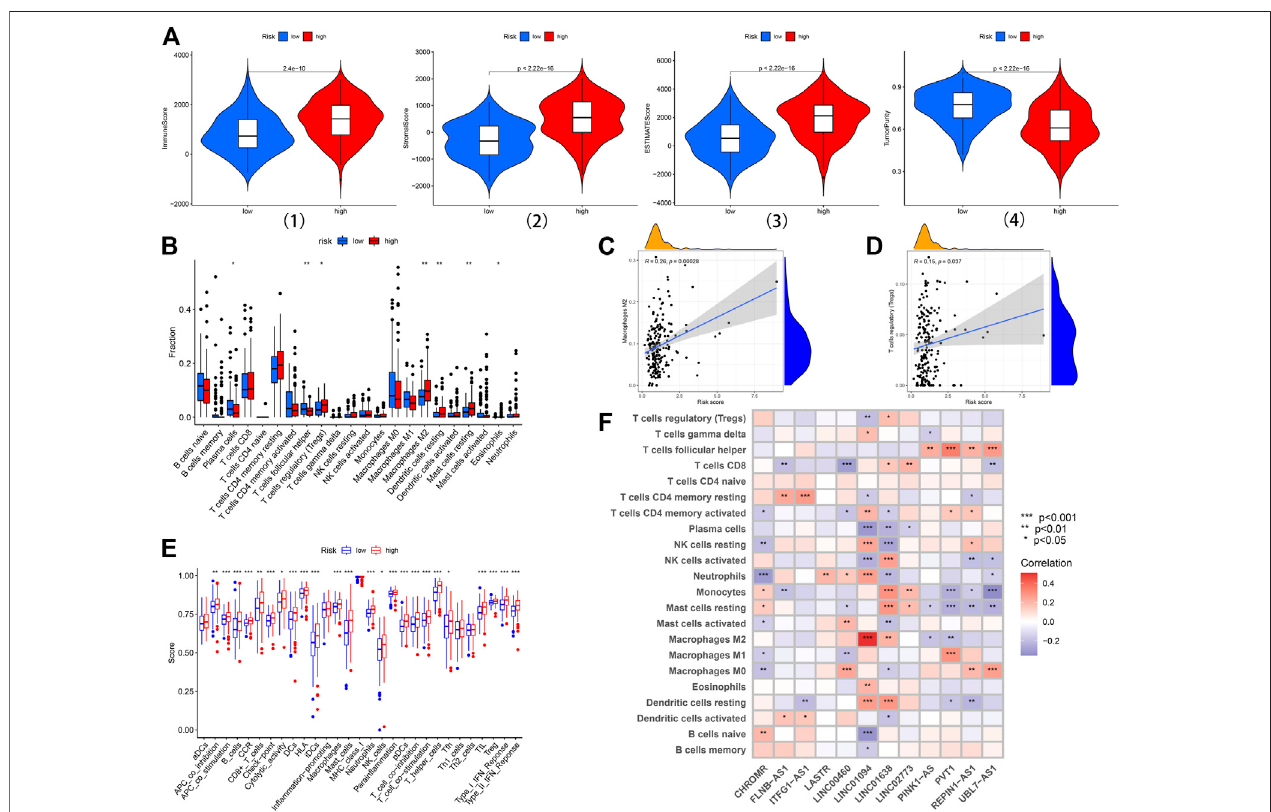
FIGURE 7 | The landscape of immune in fi ltration in the high-risk and low-risk subsets. (A) Comparison of the immune score, stromal score, ESTIMATE score, and tumor purity in the low-risk and high-risk subsets. (B) Difference analysis of 22 immune cells in fi ltration between the high-risk and low-risk subsets. (C, D) Correlation analysisbetween in fi ltrating level ofmacrophages M2, and Tregsand riskscore. (E) Immune functional differences betweenthe low-riskand high-risk subsets based on the ssGSEA scores. (F) The correlation analysis between the risk signature and in fi ltration immune cells. *: p < 0.05 **: p < 0.01 ***: p <